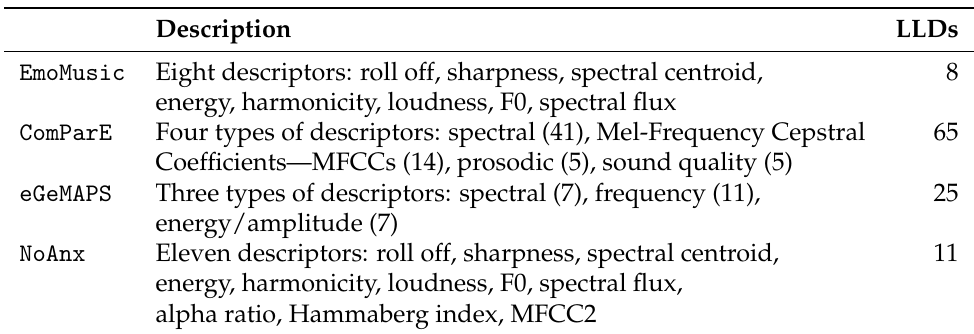
Table 1. Description and number of Low Level Descriptors (LLDs) for each of the acoustic feature sets: EmoMusic , ComParE , eGeMAPS , and NoAnx